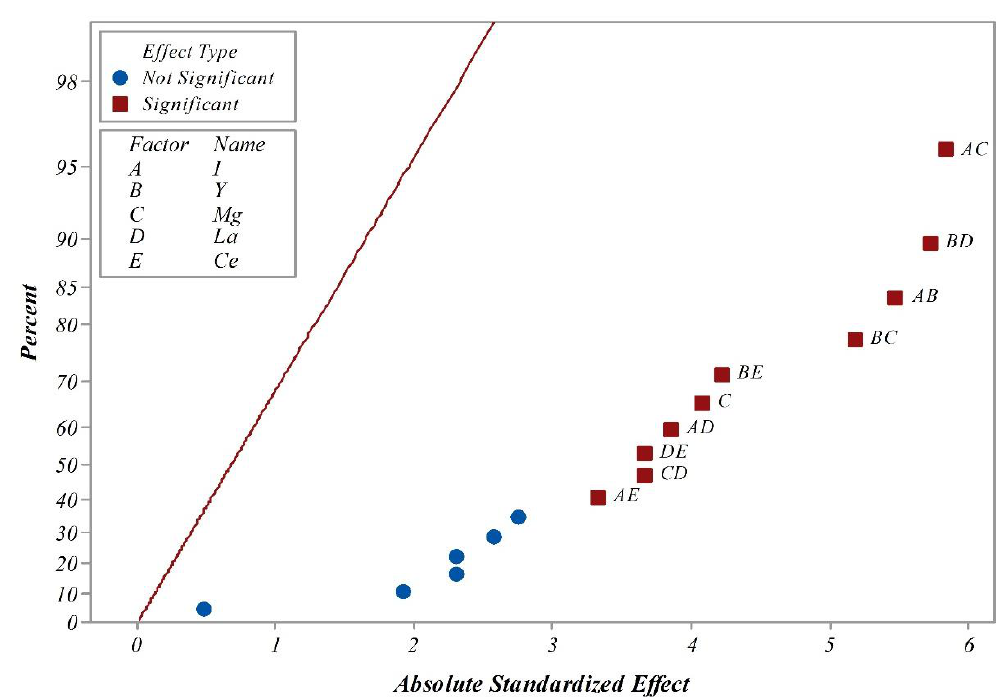
Fig. 4. Half normal plot of the standardized effects for viscosity, α =